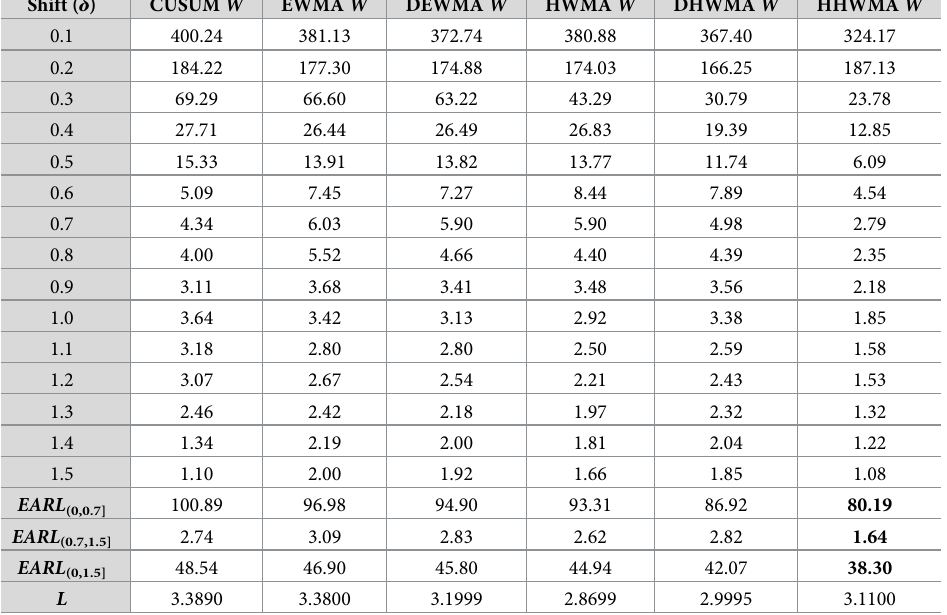
Table 5. The OOC ARL profiles of the proposed HWMA, DHWMA and HHWMA W schemes against the CUSUM, EWMA and DEWMA W schemes when ( m , n , λ )= (100,5,0.5) for a nominal ARL 0 = 500 under N (0,1) distribution.